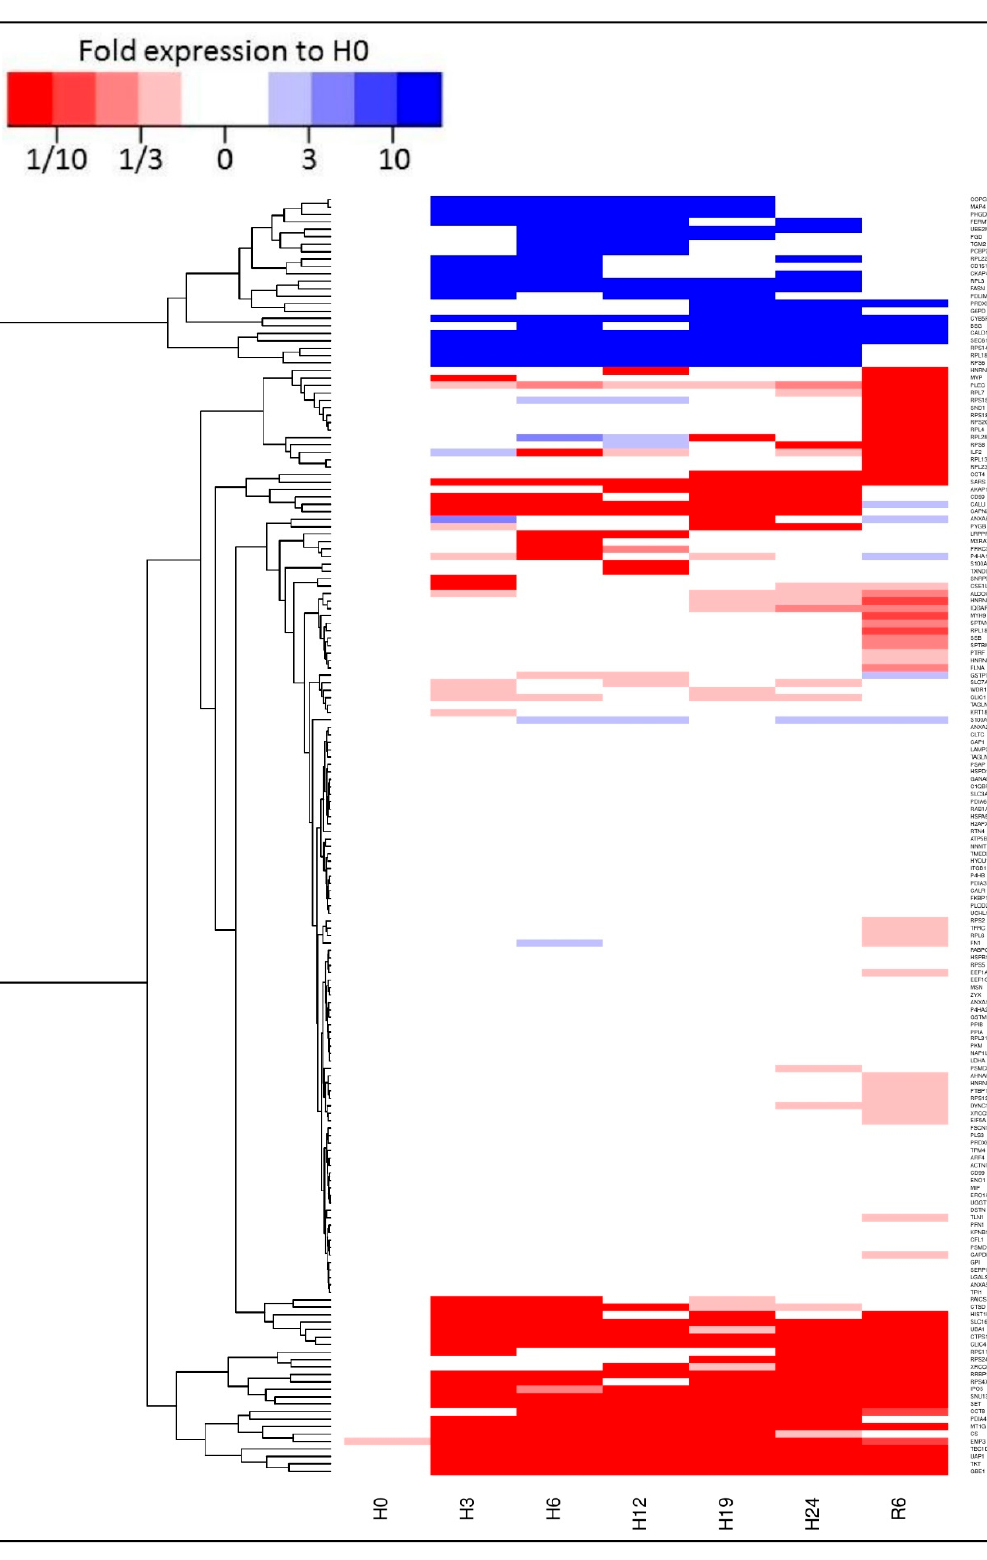
Figure 2. Proteome heatmap. A heatmap was generated using the R software, highlighting three groups of protein motifs using as criteria a variation of expression of more than 2 folds between the conditions: proteins unchanged by the protocol (white), protein increasing in expression (Blue), and protein decreasing in expression (Red).